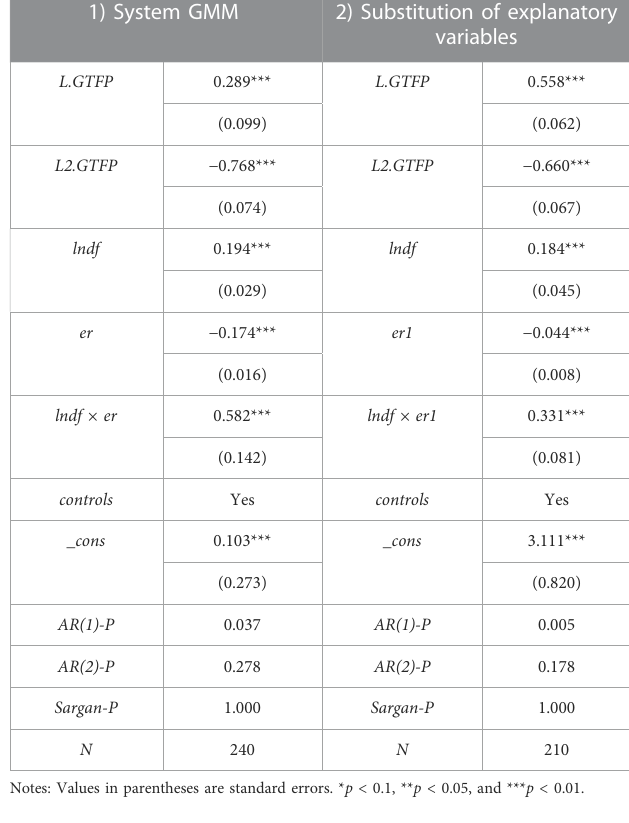
TABLE 4 Endogeneity test: IV-2SLS. Variable